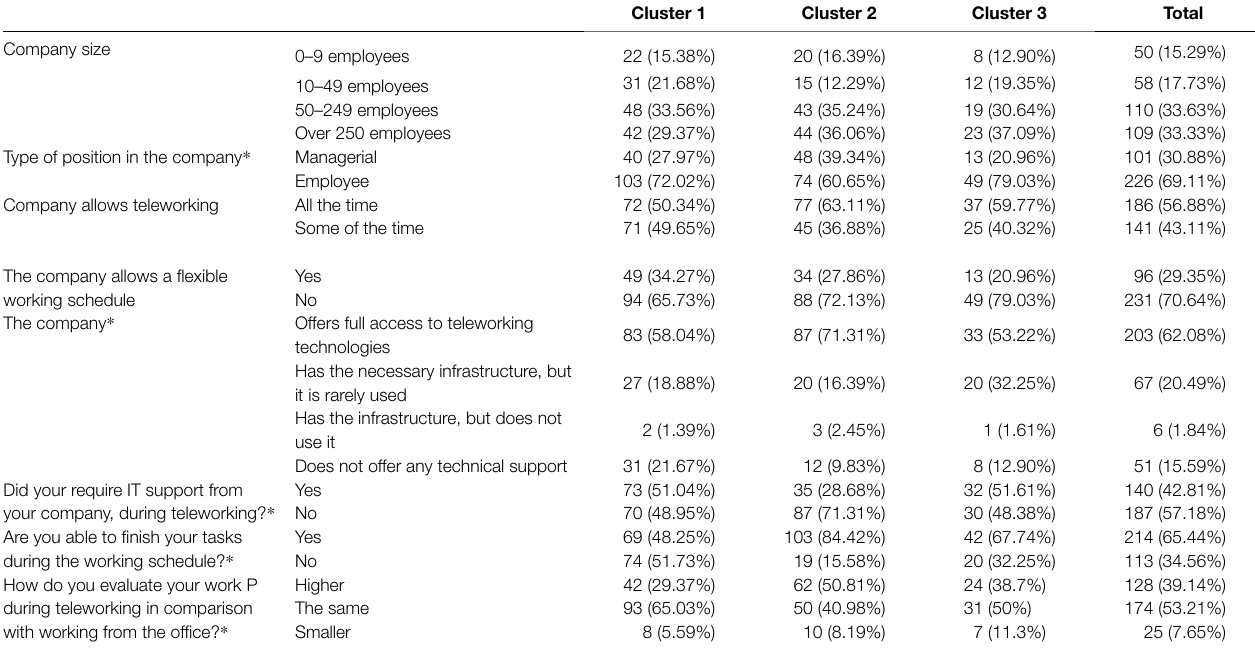
TABLE 3 | Employment and teleworking conditions per cluster.